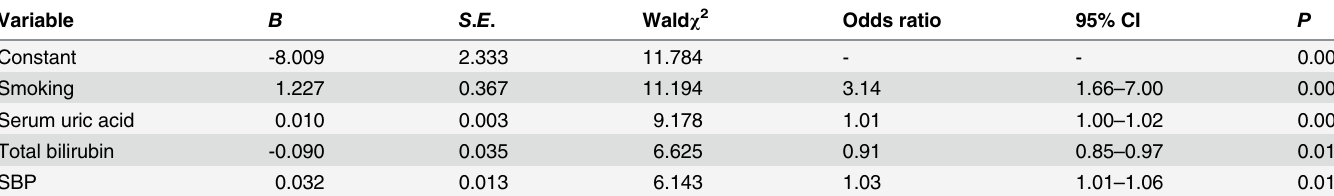
Table 4. Multivariable logistic regression analysis of prediction of